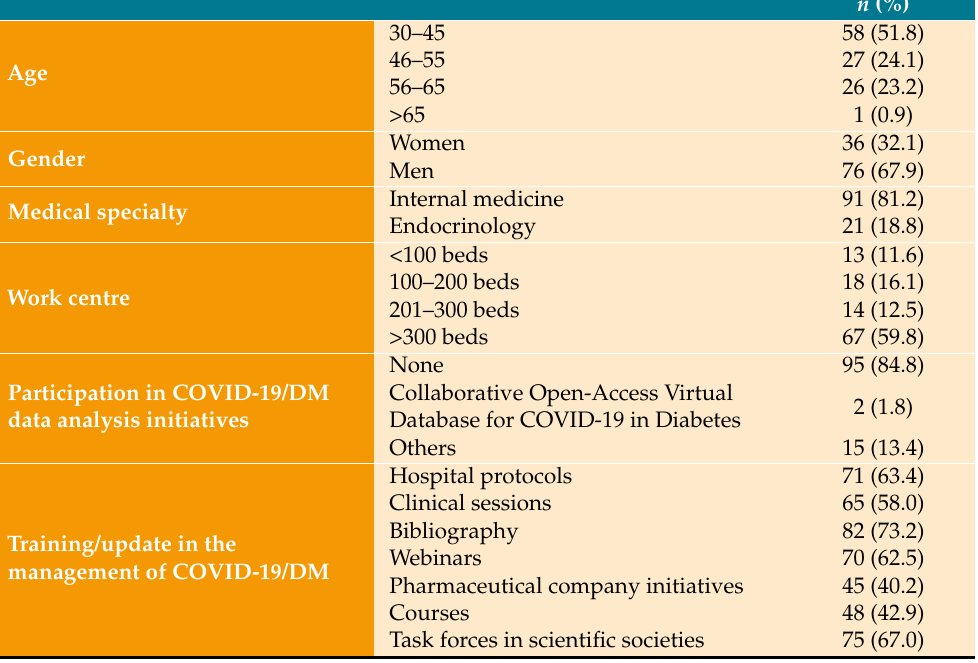
Table 1. Characteristics of participants ( n =